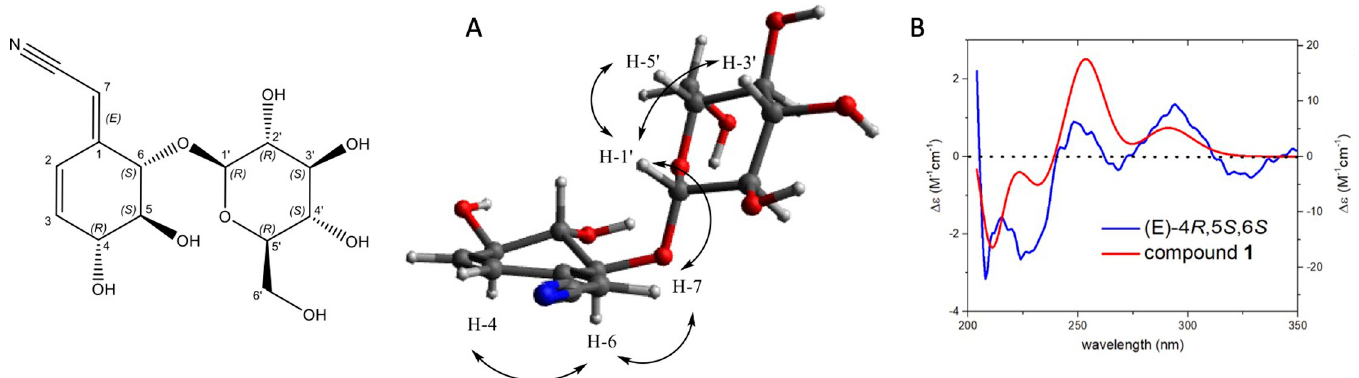
Fig 4. ( A ) NOESY correlations observed for compound 1 . ( B ) Experimental (red) and TDDFT calculated (blue) ECD spectra of enantiomer (E-4 R , 5 S , 6 S ) of compound 1 at the CAM-B3LYP/6-31G �� level.